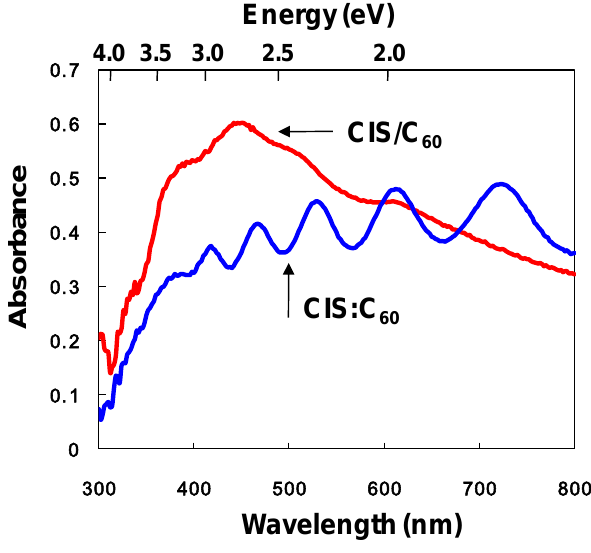
Figure 9. X-ray diffraction pattern of CIS:C